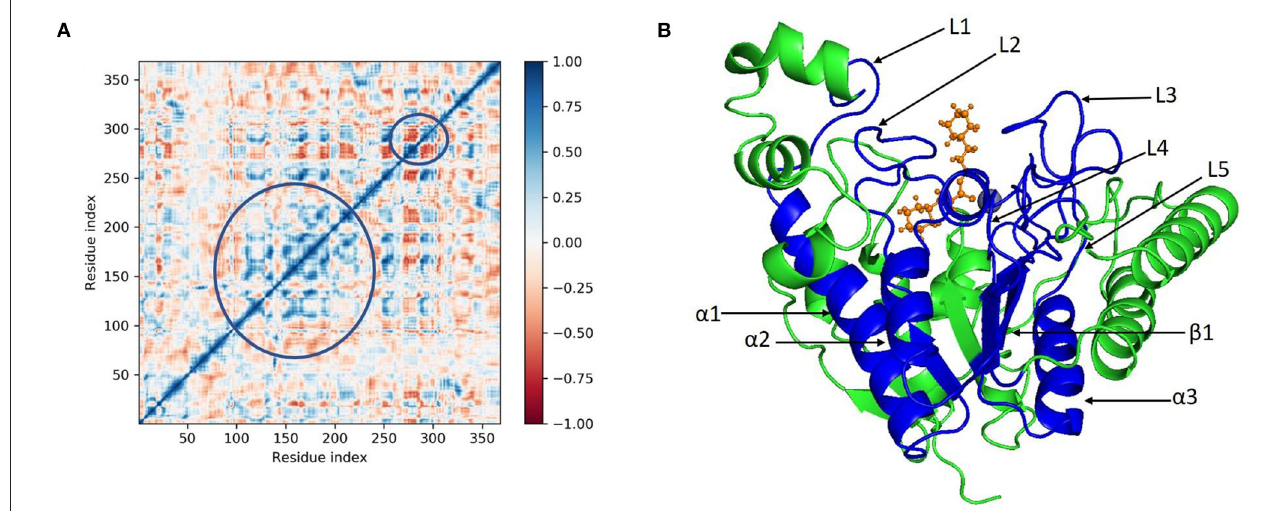
FIGURE 8 | (A) Dynamic cross correlation matrix (DCCM) and (B) correlated amino acids conformed into secondary structural domains (colored; blue) and non-correlated domains (green) of cinnamyl dihydrocinnamate (CMNPD5348) in complex with HDAC 2 from MD simulation trajectories.